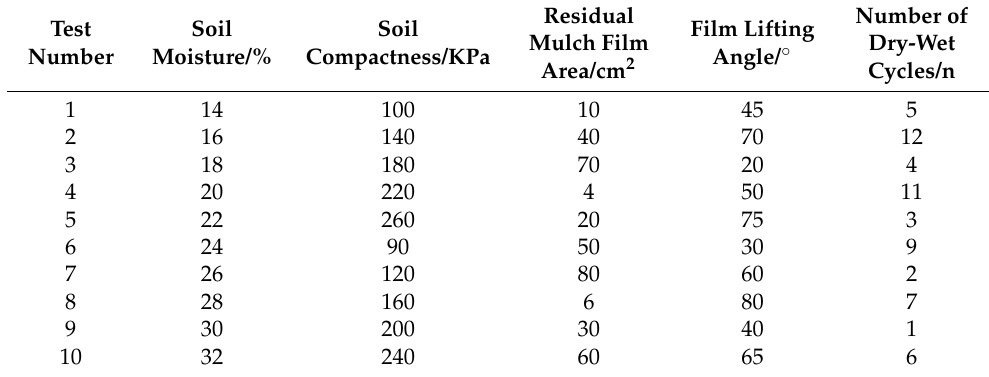
Table 1. Design scheme for uniformity test of residual film lifting